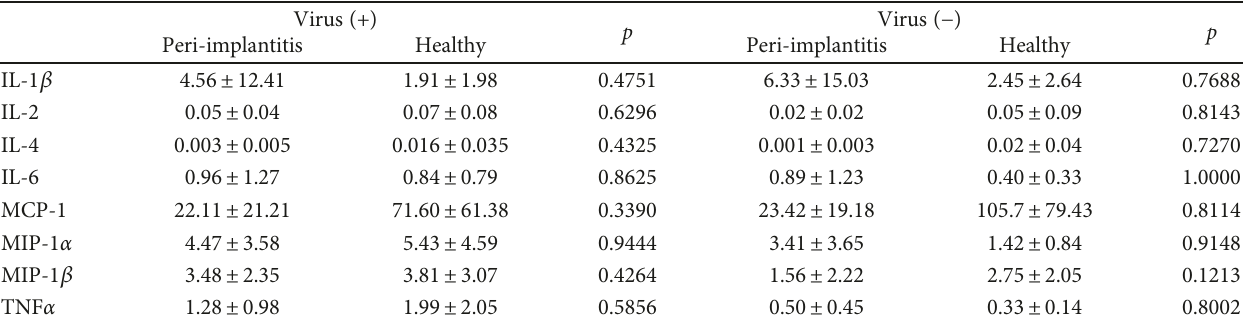
Table 6: Comparison of the frequency of virus-positive (+) subjects and virus-negative ( − ) subjects between the peri-implantitis and healthy groups. Student ’ s t -test and Mann – Whitney test ( p > 0 05